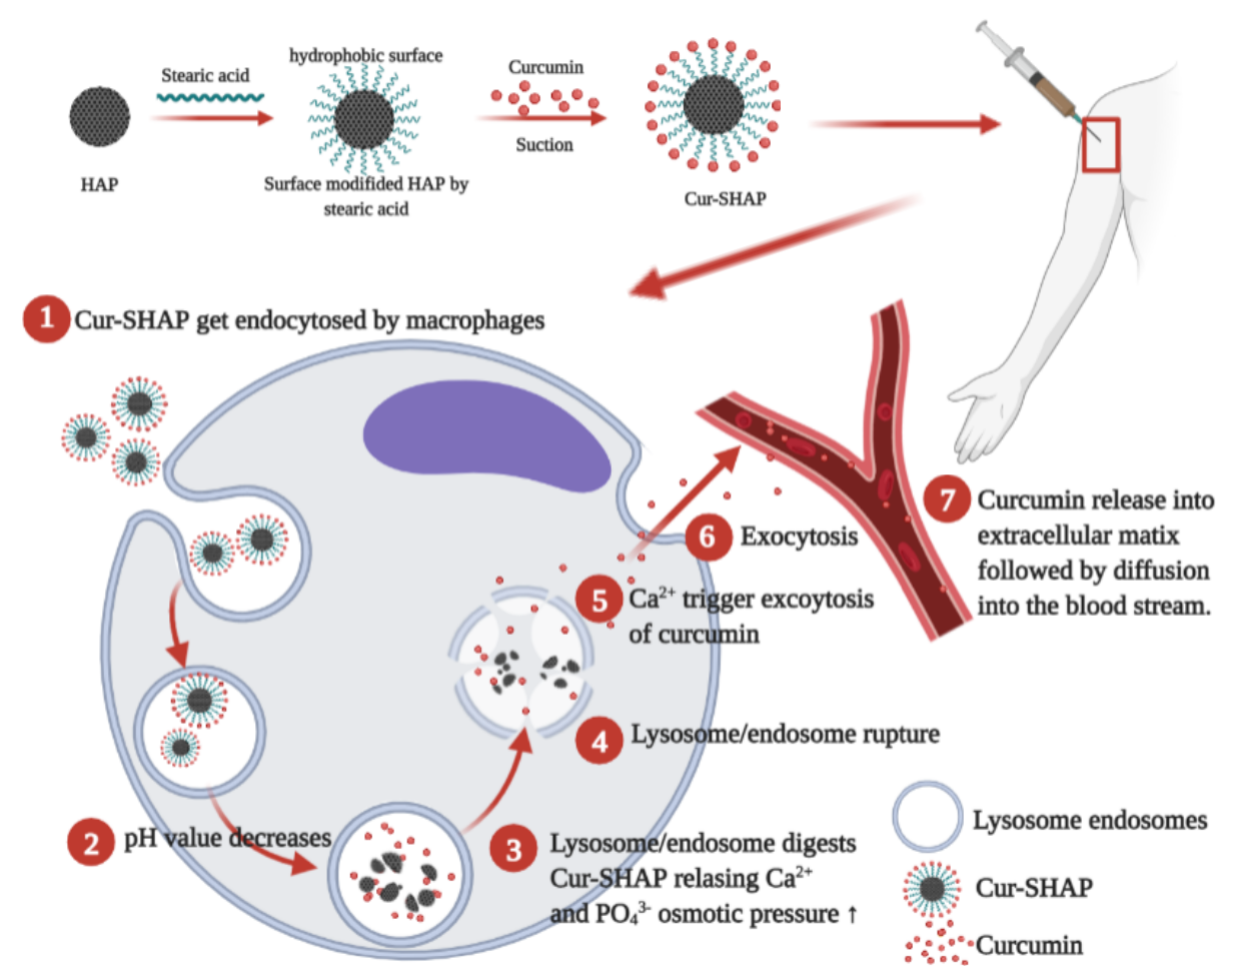
Figure 1. The bioactive Cur-SHAP particle and its in vivo delivery via the intramuscular (IM) route. The sequence of steps used to synthesize Cur-SHAP particles is shown. The method employed to administer the Cur-SHAP particles via IM is indicated, along with the steps and mechanisms involved in the delivery of curcumin to the blood circulation